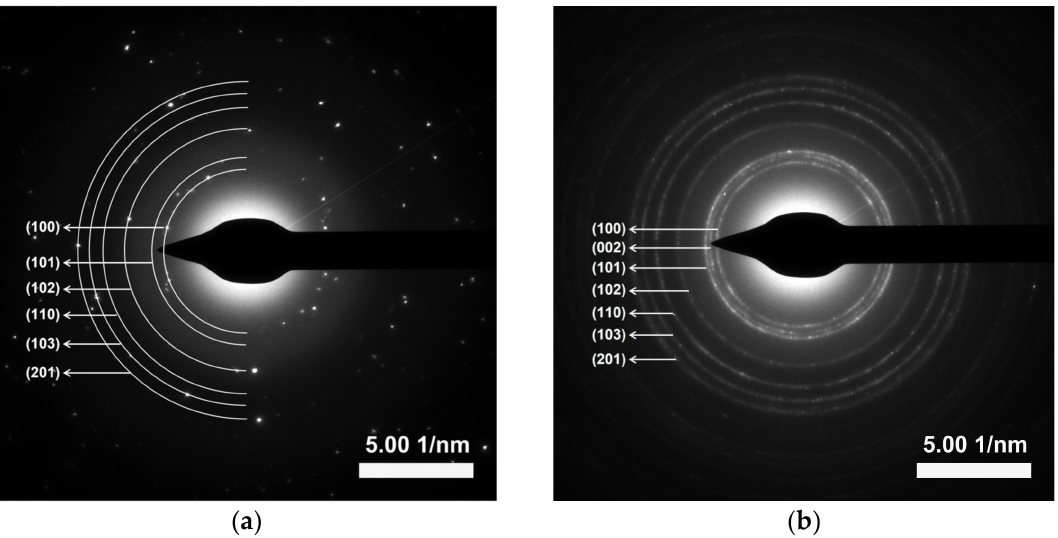
Figure 6. SAED ring-like patterns of ZnO NPs prepared by ( a ) precipitation and ( b ) combustion. Figure 7a depicts the Raman shift for vibrational analysis of ZnO NPs. The ZnO NPs revealed dominant peaks at 100 and 440 cm − 1 , which assigned the E 2 (low) and E 2 (high) modes, respectively [29,30]. The E 2 (low) vibration represented the zinc crystal lattice in ZnO, while the E 2 (high) vibration represented the oxygen vibration. The peaks at 334, 384, 542, and 585 cm − 1 were assigned to the E 2 (high)–E 2 (low), A 1 (TO), A 1 (LO), and E 1 (LO) modes, respectively [31]. The peak at 223 could be assigned to 2TA or 2E 2 (low) modes. [30,32]. These peaks indicate the disordered structures for both ZnO NPs prepared by precipitation and combustion. Moreover, the E 2 (low) and E 2 (high) modes show low intensity compared with the ZnO precipitation. These behaviors suggest the presence of oxygen defects in the ZnO combustion. In Figure 7b, FTIR spectra in the range of 4000–450 cm − 1 were analyzed to investigate functional groups of the ZnO NPs. The peaks at 490 cm − 1 contributed to the ZnO structure, due to the Zn-O vibration [33]. The peaks at 819 and 1647 cm − 1 corresponded to C=O stretching [11]. The peaks at 1320 and 1435 cm − 1 corresponded to C-O stretching and C-H blending, respectively [11]. The peaks at 3391 and 3497 cm − 1 were assigned to the O-H stretching. The appearance of these peaks implies the presence of residuals.